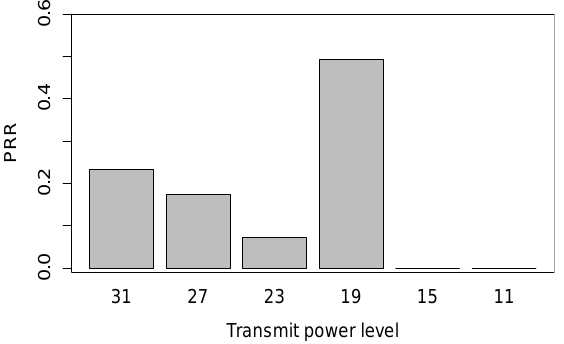
Figure 5. PRR distributions vs. transmit powers of the link B-Aof the distance of 28 m under the Bajia